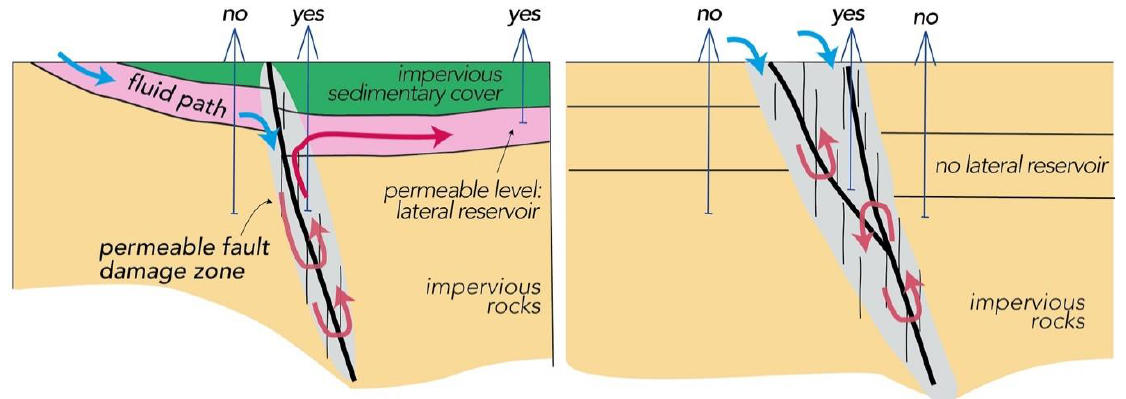
Figure 3. Geological sketches (not to scale) illustrating the two end-member geothermal systems; left: the fluid flow is controlled by permeable fault damage zones and by a permeable level (lateral reservoir) hydraulically connected to the main structural channel. Right: the fluid flow is limited to the fault damage zone.